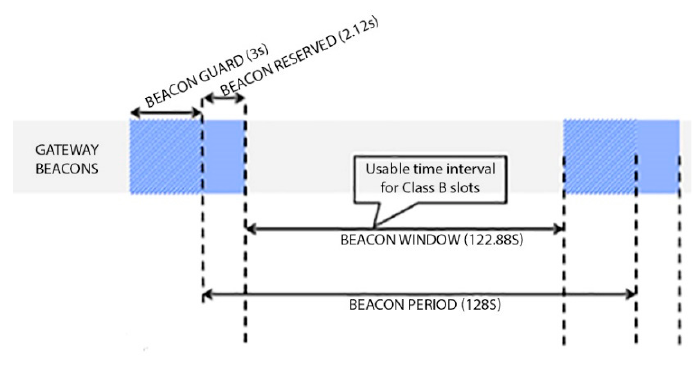
Figure 4. Class B beacon window temporal parameters .